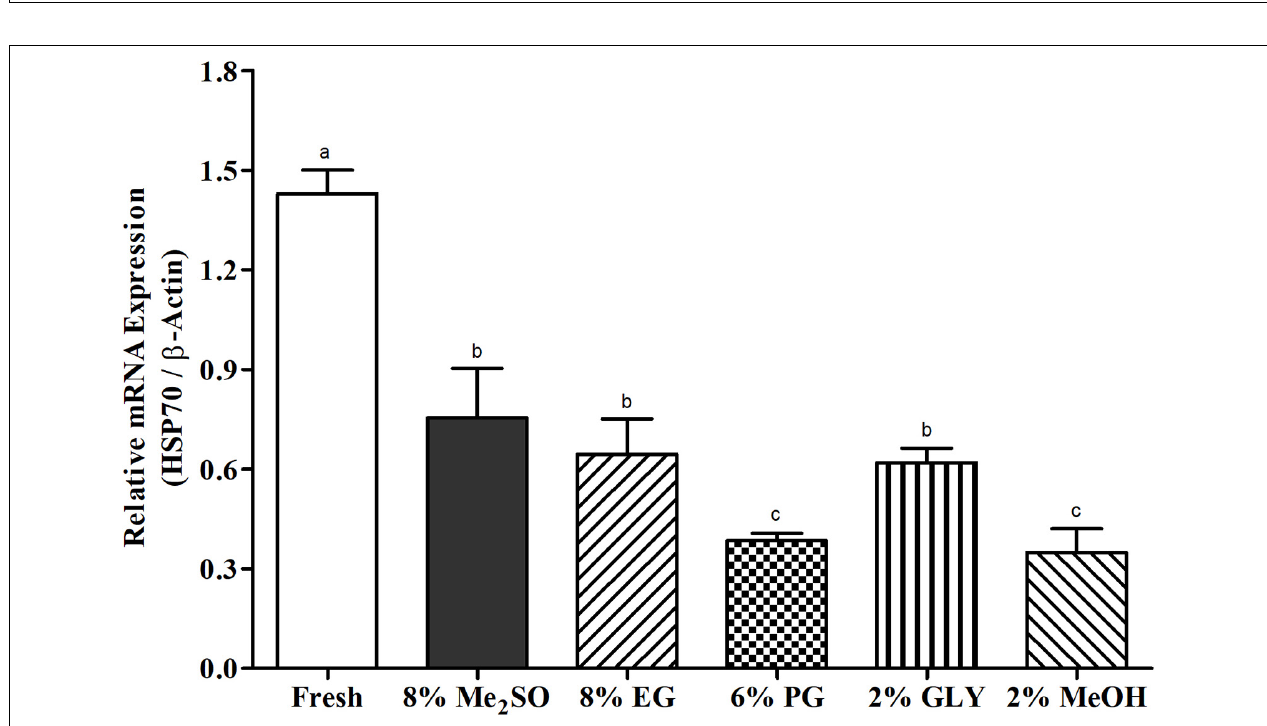
FIGURE 1 | PKA-C mRNA expression levels in fresh and cryopreserved sperm samples ( n = 3) of Pacific abalone, H. discus hannai . Expression values of PKA-C mRNA were normalized against average (cid:49) CT values of control. Different superscript letters (a–c) above bars indicate significant ( p < 0.05) differences between fresh and cryopreserved sperm samples.